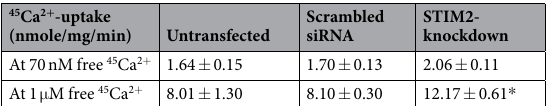
Table 3. 45 Ca 2 + -uptake from the cytosol into the SR through SERCA1a in the STIM2-knockdown mouse primary skeletal myotubes. Either an untransfected or a scrambled siRNA-transfected control was used as a negative control. The results are presented as the mean ± S.E. of three independent experiments. * Significant difference compared with the untransfected control ( p <